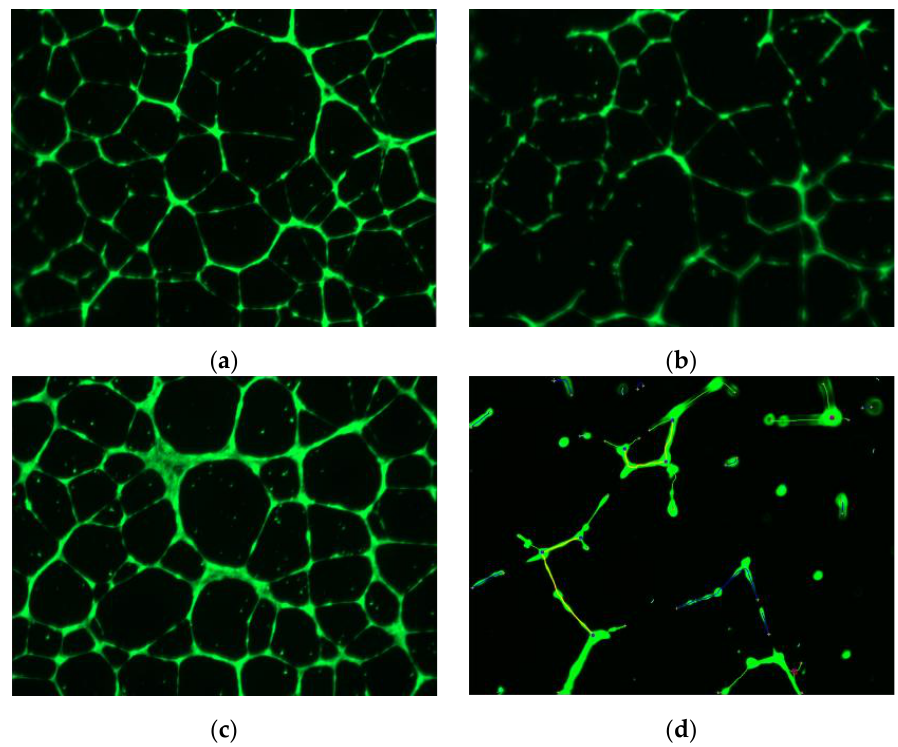
Figure 2. Squalamine inhibits capillary tube-like formations and the skeleton of tubular networks formed in an Endothelial Tube Formation Assay. Human umbilical vein endothelial cells (HUVEC) were grown in medium without serum on the surface of Geltrex (Thermofisher) in the presence of the following conditions: ( a ) control vehicle, ( b ) squalamine 1 µ M; ( c ) VEGF 50 ng/mL and ( d ) VEGF (50 ng/mL) + squalamine 1 µ M for 18–24 h. Tubular structures formed by endothelial